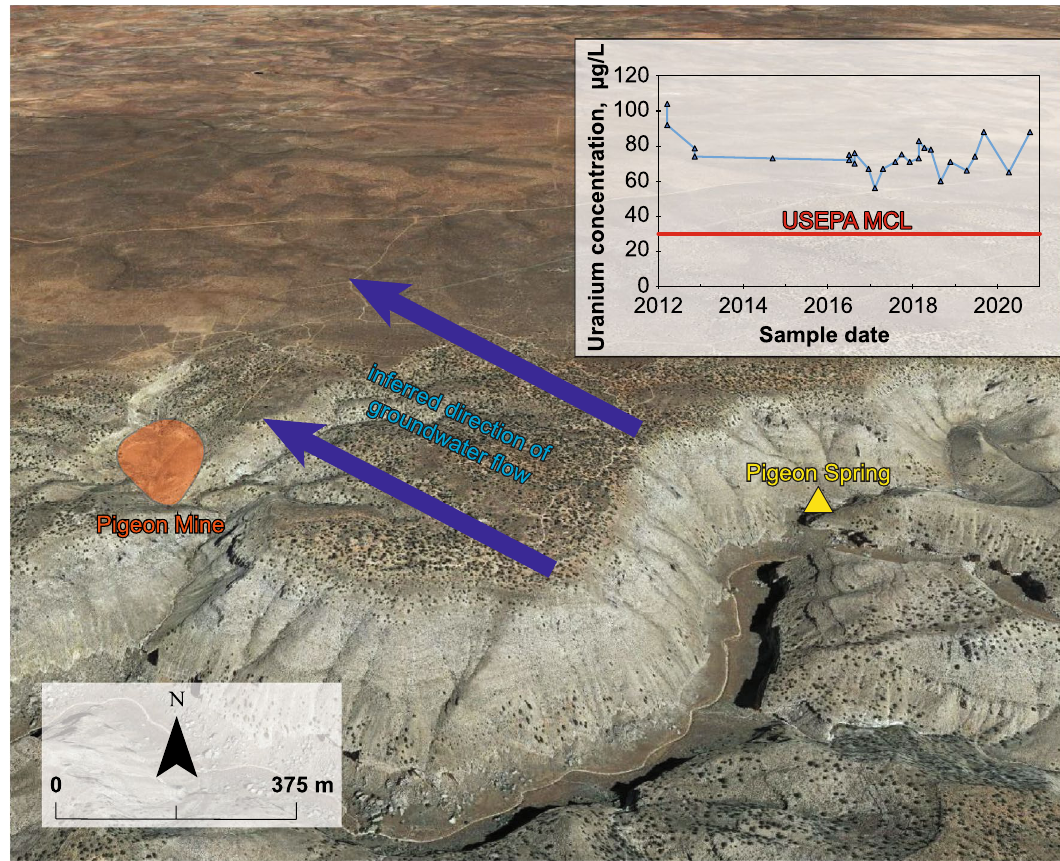
Figure 5. Map of Pigeon Spring and the former Pigeon Mine with uranium concentrations through time at the spring and inferred direction of groundwater flow from Beisner et al. 62 . Created in Adobe Illustrator 25.4.1 (https:// www. adobe. com/ produ cts/ illus trator. html). Oblique imagery from Google, remained in the mine 29 . As of 2021, the National Park Service continues to evaluate the site to determine if cleanup action is required. Groundwater discharges from rock units and streambed alluvium at several locations in the Horn Creek drainage and uranium concentrations in groundwater vary greatly among these sites (Fig. 6). The highest ura- nium concentration in groundwater at Horn Creek, and the highest concentration observed at any groundwater site sampled by USGS in the region, is 293 µg/L from a sample on June 2, 2020, at site “Upper Horn Bedrock Spring” (H1 in Fig. 6). This spring issues from the Redwall–Muav aquifer at the canyon wall just downslope from the Orphan Mine. The first documented sampling of this site for uranium was in 2002 with reported uranium values as high as 400 µg/L 65 (which was not part of a USGS study, and thus not included in the current dataset). Uranium concentrations at this spring have varied considerably since USGS began monitoring the site in 2018, with concentrations as low as 151 µg/L in January 2020, just 6 months before the high of 293 µg/L (Supplemen- tary Table S1). Uranium concentration fluctuations may be due to changes in recharge amount and seasonality and is part of ongoing investigation. Observed pH values of 7.4–8.2, oxic dissolved oxygen concentrations of 8.2–10.1 mg/L, and the presence of bicarbonate from 148–154 mg/L (Supplementary Table S1) result in expected mobile uranium carbonate speciation (Supplementary Fig. S6). As the water flows down the Horn Creek drain-